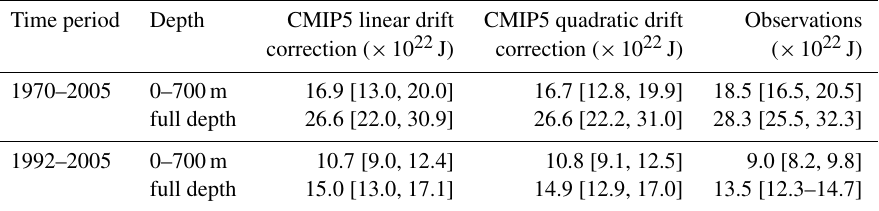
Table 3. Summary of total ocean heat content change within 1970–2005 and 1992–2005 by using an alternative method to assess the long- term OHC change. Here the total OHC changes based on observations are calculated by the difference of OHC with 2004–2006 and OHC within 1969–1971 (1990–1992) for the 1970–2005 (1992–2005) period to reduce the interannual temporal variability. This is an alternative method to assess the OHC change in addition to the linear trend in Table